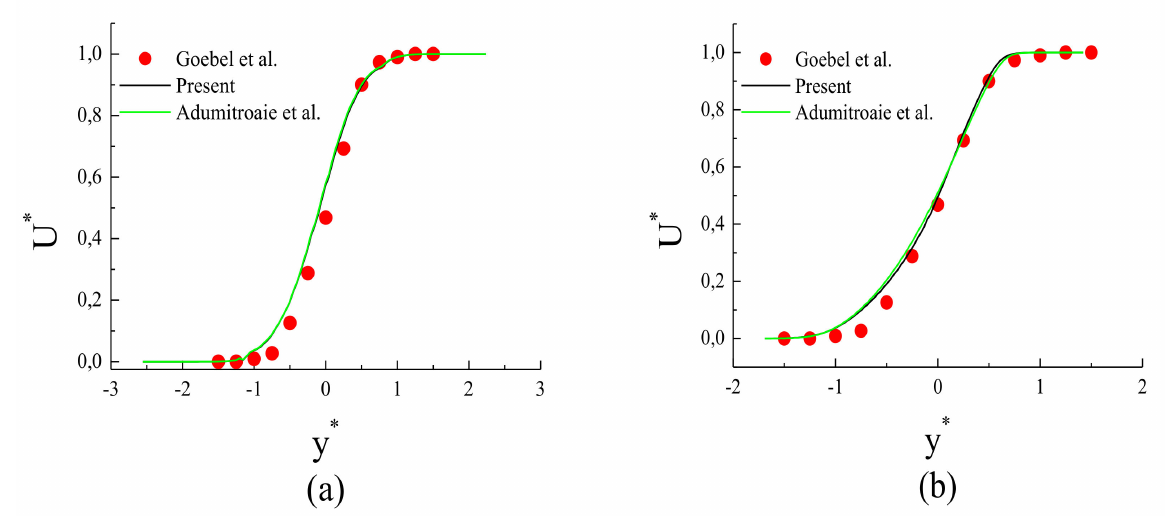
Figure 10. Similarity profiles of the mean velocity, in the following cases: ( a , b ).